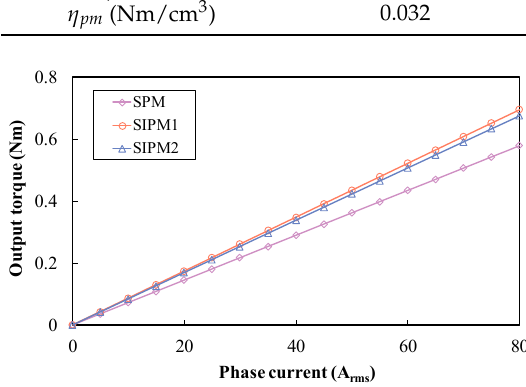
Figure 12. Output torque versus phase current.